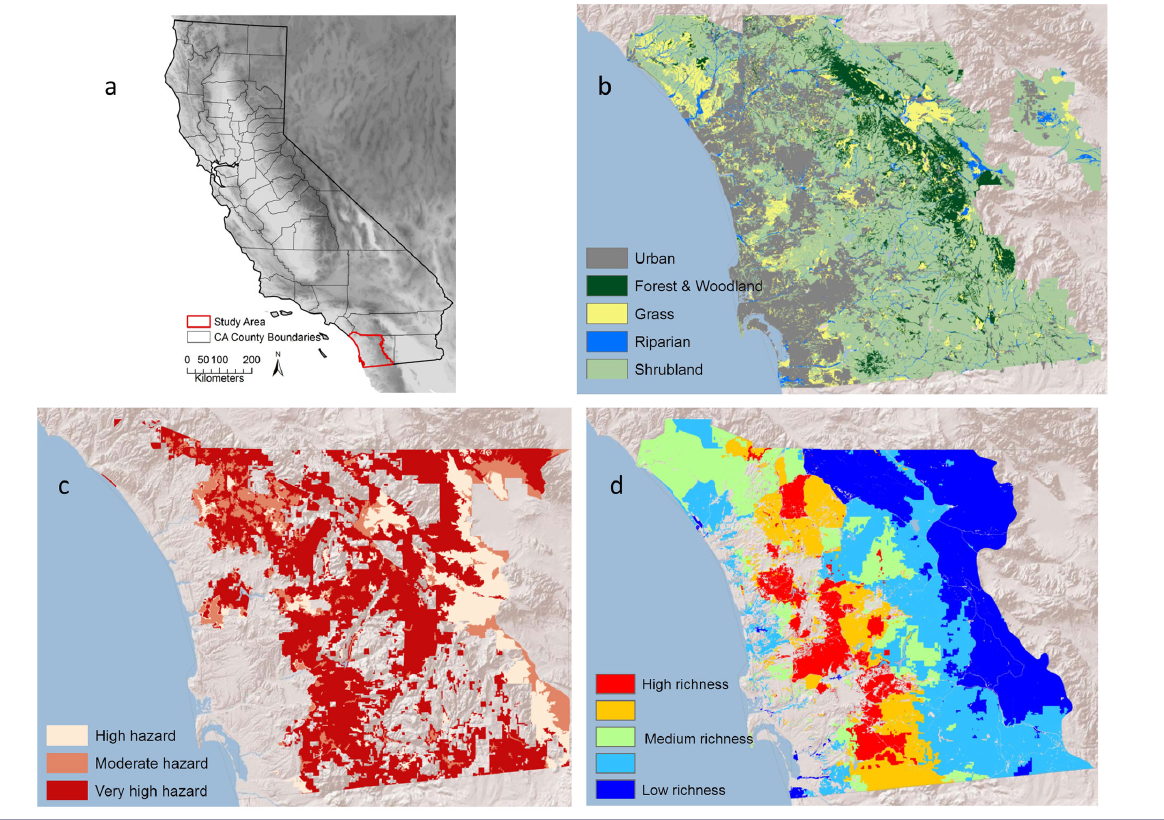
Fig. 1 . Maps of (a) study area, (b) major vegetation types, and priority conservation areas for (c) reducing fire hazard, and (d) maximizing species